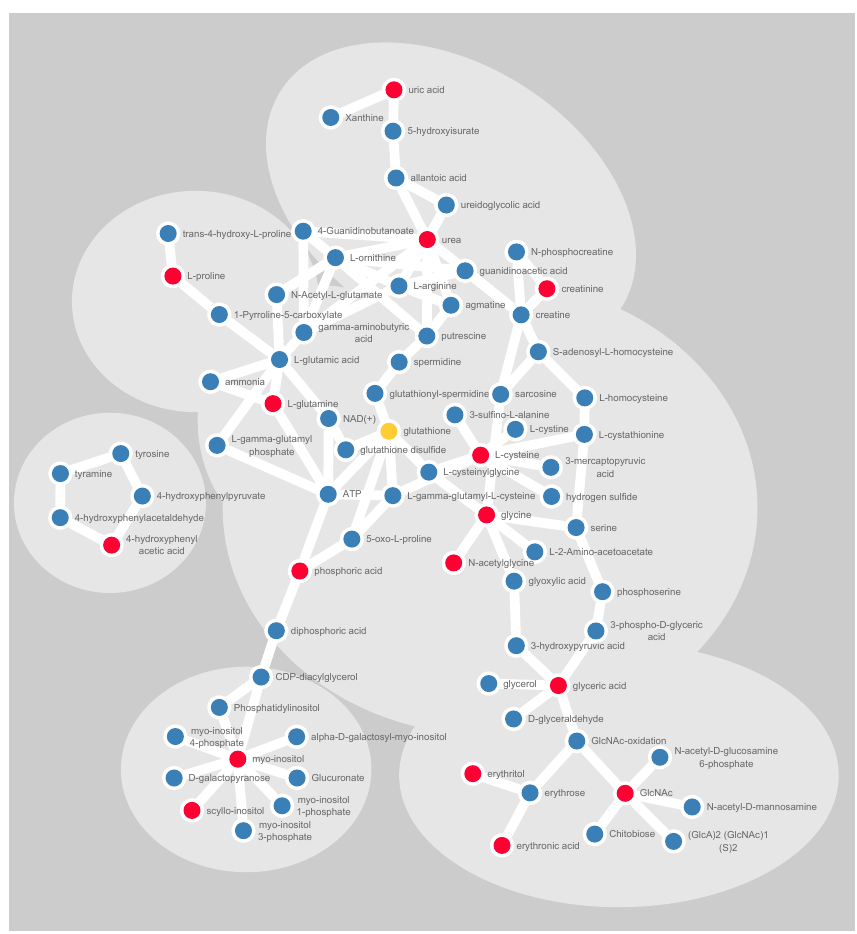
Figure 6. Schematic illustration of significantly altered metabolites (red) and their closest derivatives and precursors (blue). Glutathione is included in yellow, being a central metabolite in redox balancing. The linkage in the illustration is based on the KEGG pathway database, for humans only. Cytoscape software was used for visualizing molecular